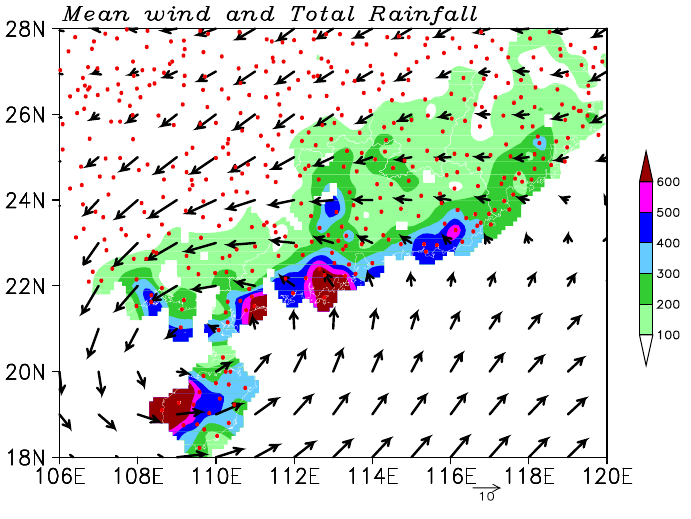
Figure 5. Ten-day total rainfall based on observations of weather stations (shaded, unit: mm) and the 10-day mean 900-hPa wind extracted from the NCEP reanalysis (vectors, unit: m·s –1 ) in the period of 28 August to 6 September 2001. The red points indicate the surface rain gauge stations.